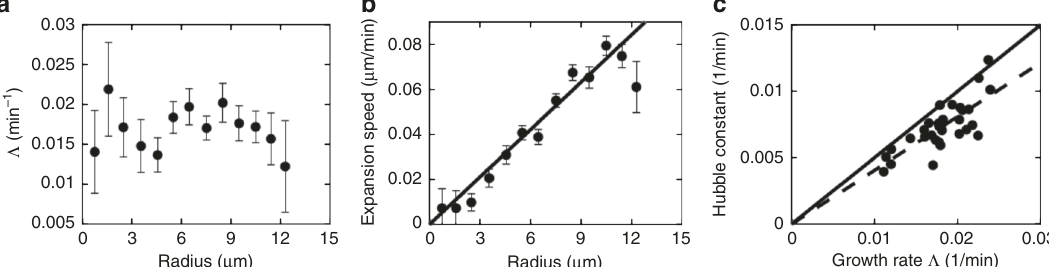
Fig. 2 ‘ Hubble ’ cellular fl ow. a Plot of azimuthally-averaged growth rate against distance from the colony centroid, averaged over 32 colonies 10 min prior to buckling. The growth rate is approximately constant spatially. Error bars are standard errors of the mean. b Plot of the azimuthually-averaged radial velocity of bacteria as a function of distance from the centroid of the colony, averaged over all colonies 10 min prior to buckling (see Supplementary Note 3 for details). Solid line: best fi t. Error bars are standard errors of the mean. c Plot of the ‘ Hubble constant ’ for the individual colonies, plotted against the bacterial growth rate. Dashed line: best fi t; solid line: H = 0.5